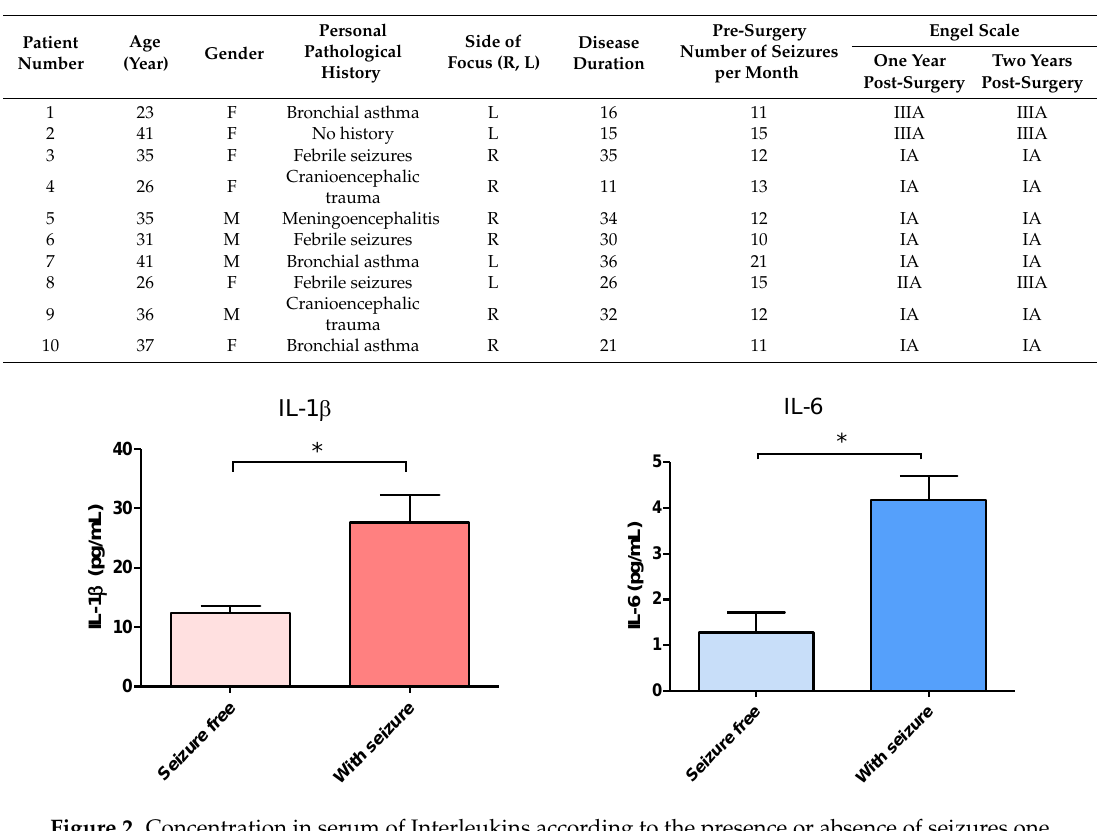
Table 2. Clinical data from patients with drug-resistant temporal lobe epilepsy submitted to temporal lobectomy.